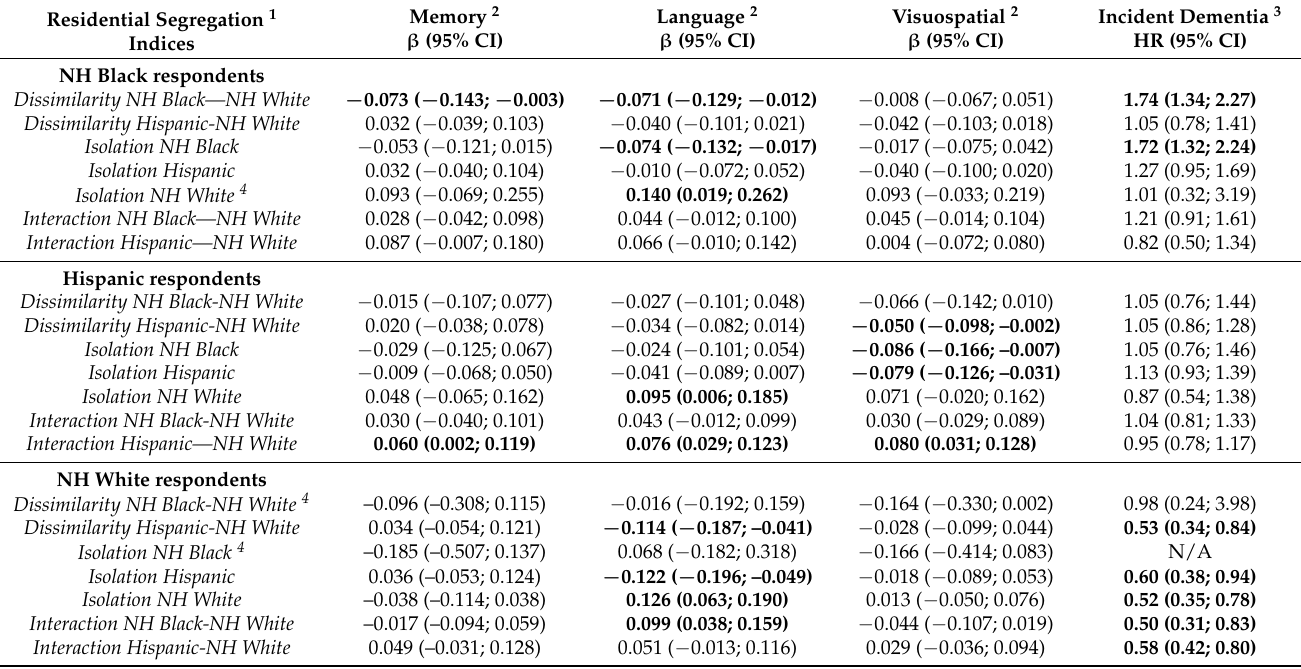
1 Racial/ethnic residential segregation indices are measured at the block group level from 2005–2009 ACS data. Dissimilarity measures the number of people who would have to move to create an equal distribution of a racial/ethnic groups in the geographic area of interest. Isolation and interaction measure the likelihood of interacting with someone in the same racial/ethnic group or in a different racial/ethnic group, respectively. For all indices, we used the mean value within our sample to create binary indicators of segregated census blocks. Higher dissimilarity and isolation indicate a block group with more people from minoritized backgrounds, whereas higher interaction indicates more desegregated areas; 2 multilevel linear models adjusted for age, sex/gender, race/ethnicity, cSES, years of education, occupation, language of test administration, birthplace, and recruitment cohort. All cognitive scores